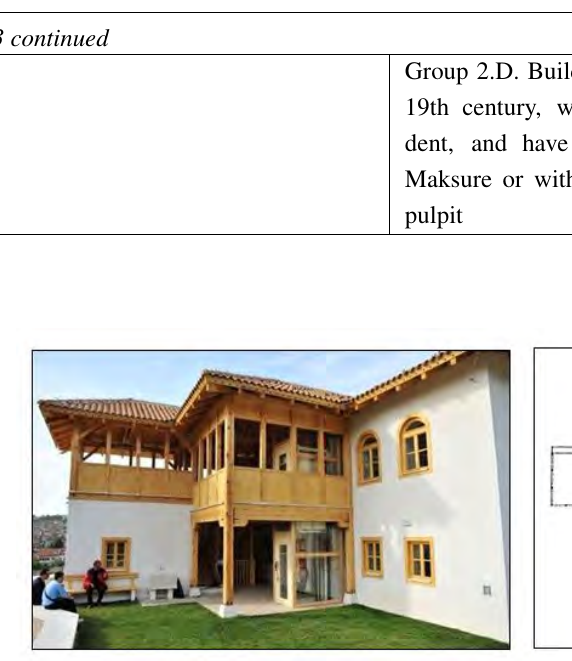
Figure 2. Sarajevo,The ˙Isabey Zaviye/ Example of Home - Tekke (TIKA, 2003)